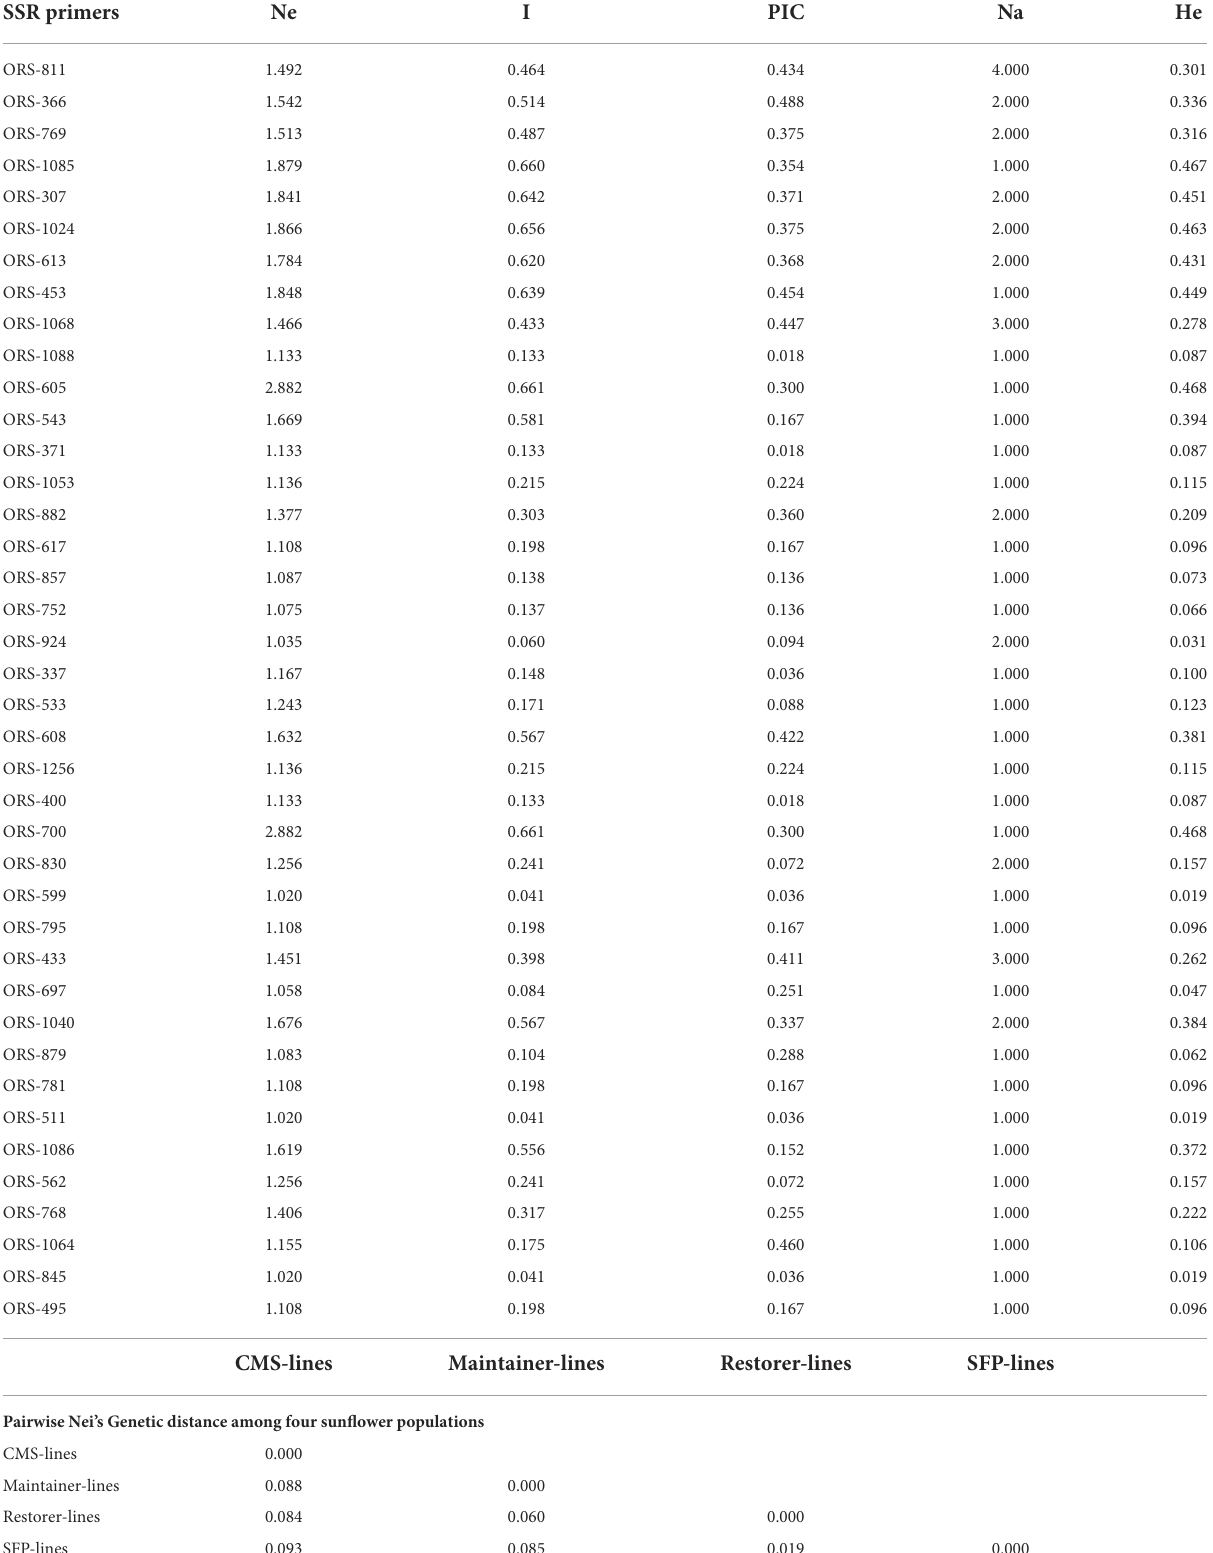
TABLE 4 Genetic diversity estimates as revealed by 40 SSR primers and Pairwise Nei’s Genetic distance among four sunflower populations. SSR